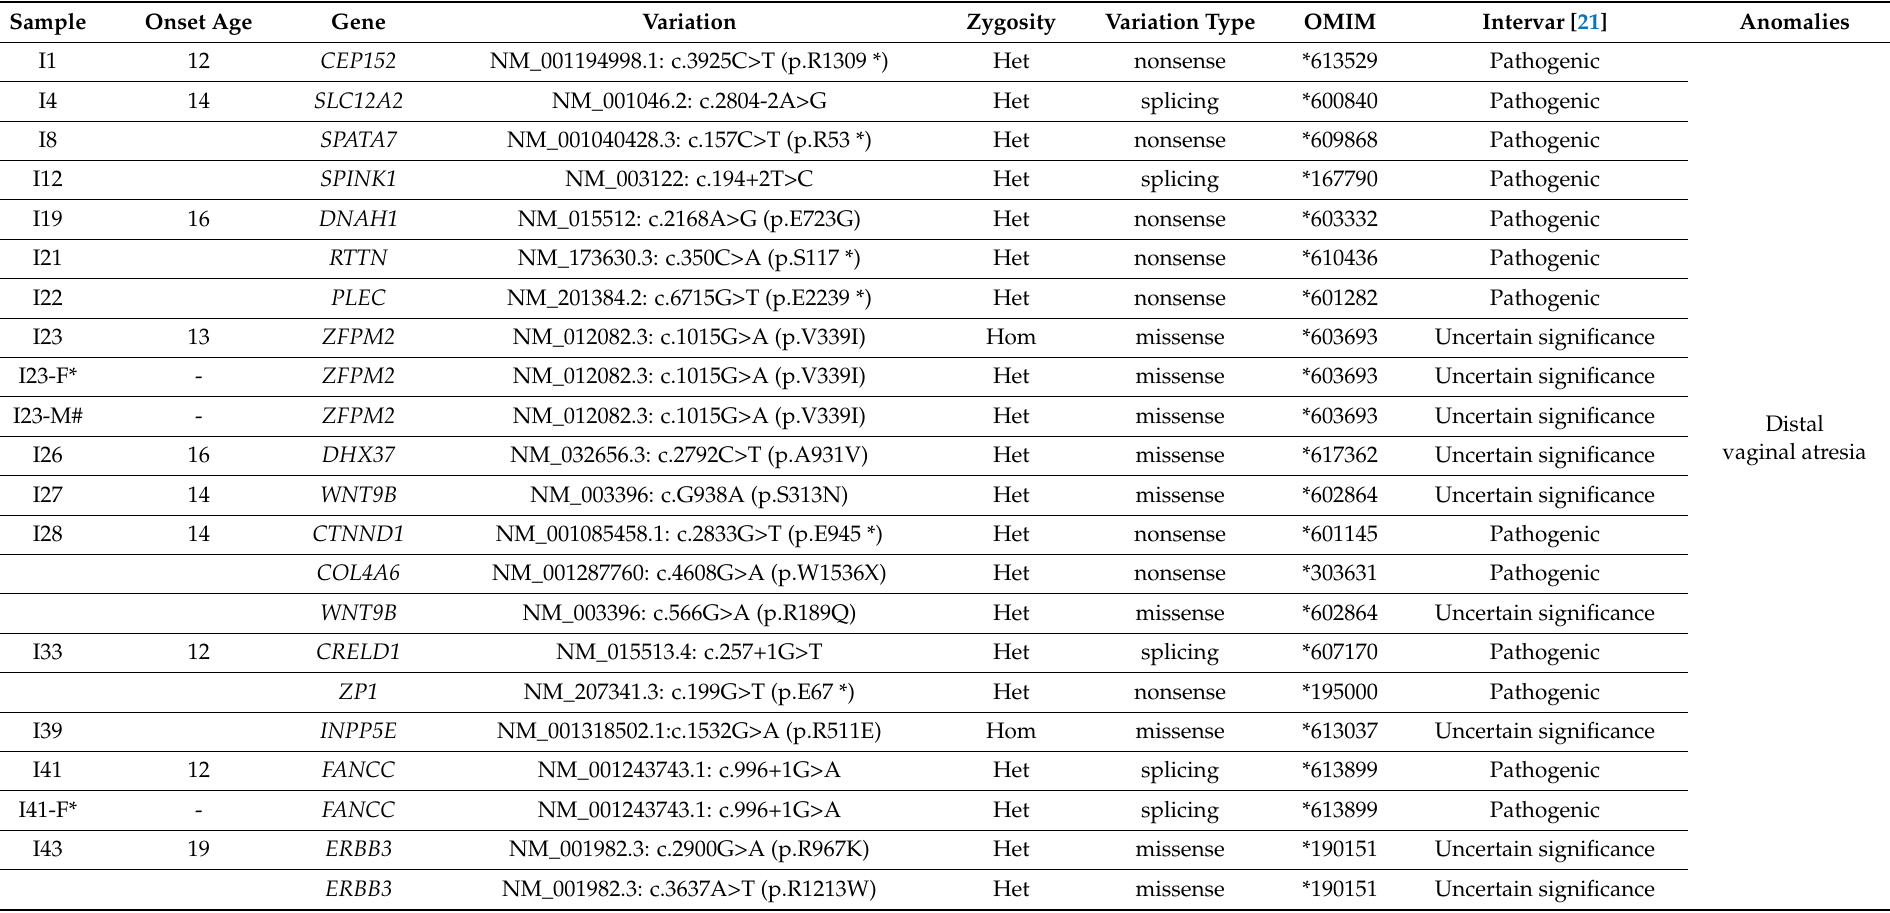
Table 3. Identification of genetic variants in patients with unique phenotypes of distal vaginal